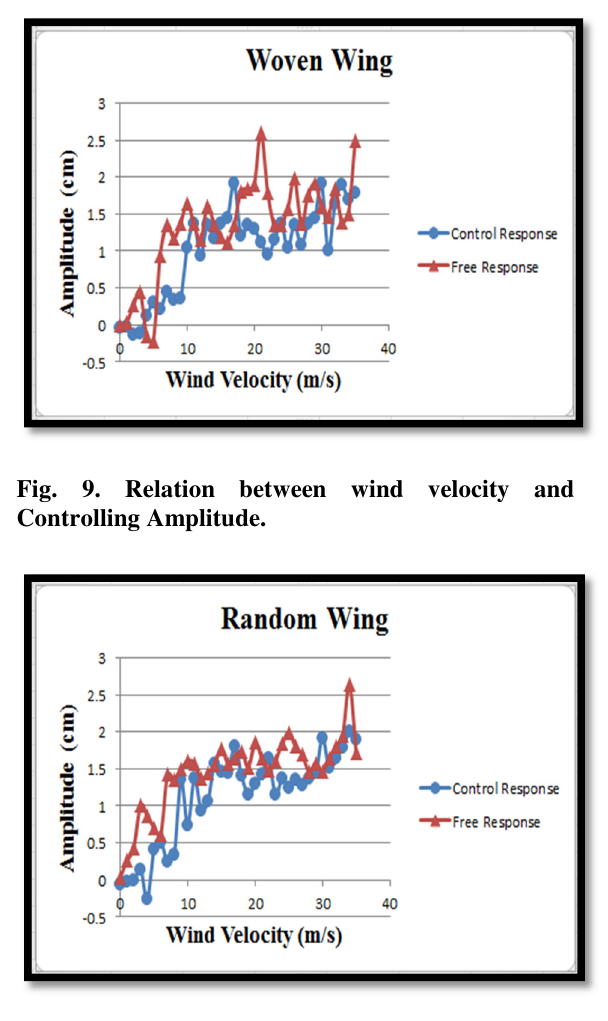
Fig. 10. Relation between wind velocity and Controlling